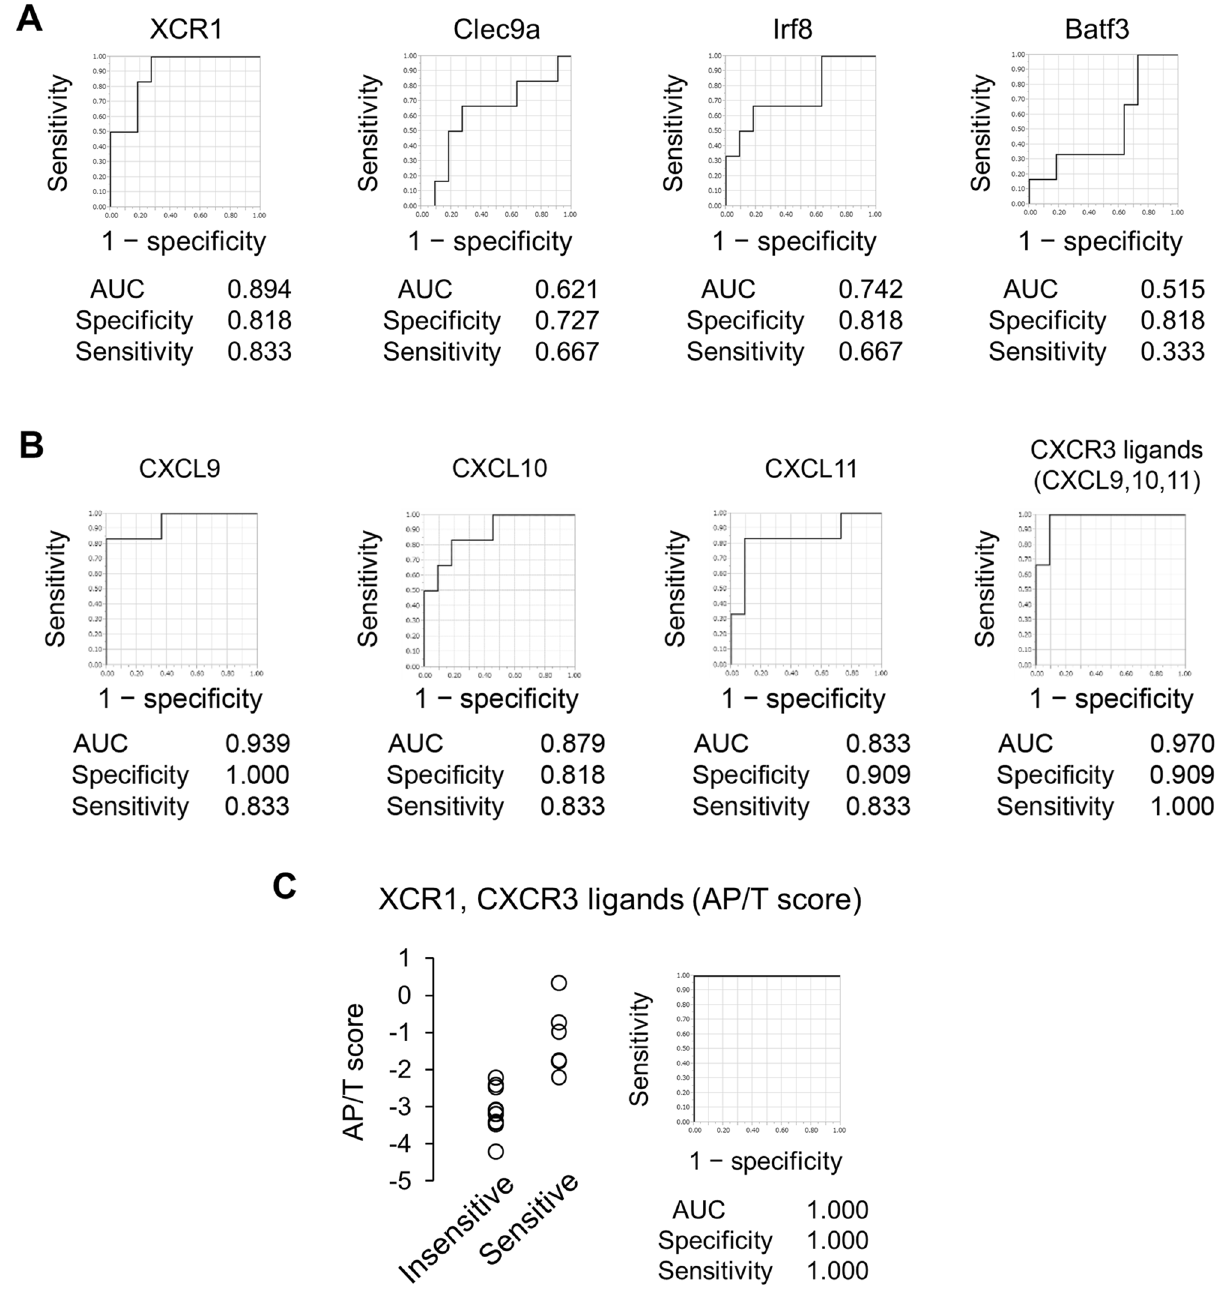
Figure 6. Relationship between antitumor activity of anti-PD-L1 mAb and antigen-presenting DC-related gene expression and/or gene expression of CXCR3 ligands in murine tumor models. ( A ) ROC curve analysis by expression of antigen-presenting DC-related genes in 17 murine tumor models. ( B ) ROC curve analysis by expression of CXCR3 ligands in 17 murine tumor models. ( C ) AP/T of anti-PD-L1 mAb-insensitive or -sensitive tumor tissues and ROC curve